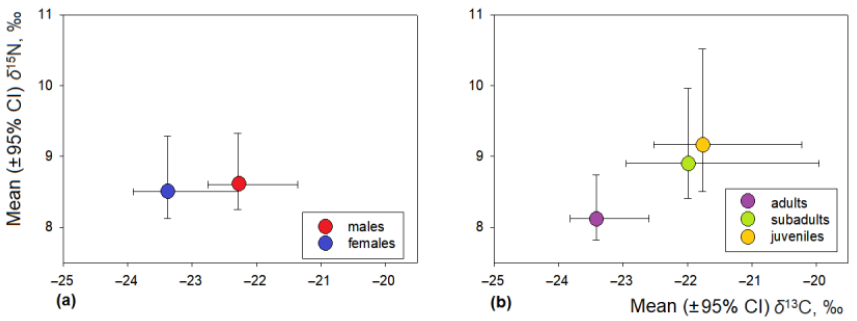
Figure 4. Intraspecific differences of the isotopic space of M. musculus : ( a ) — gender-based; ( b ) — age- based.